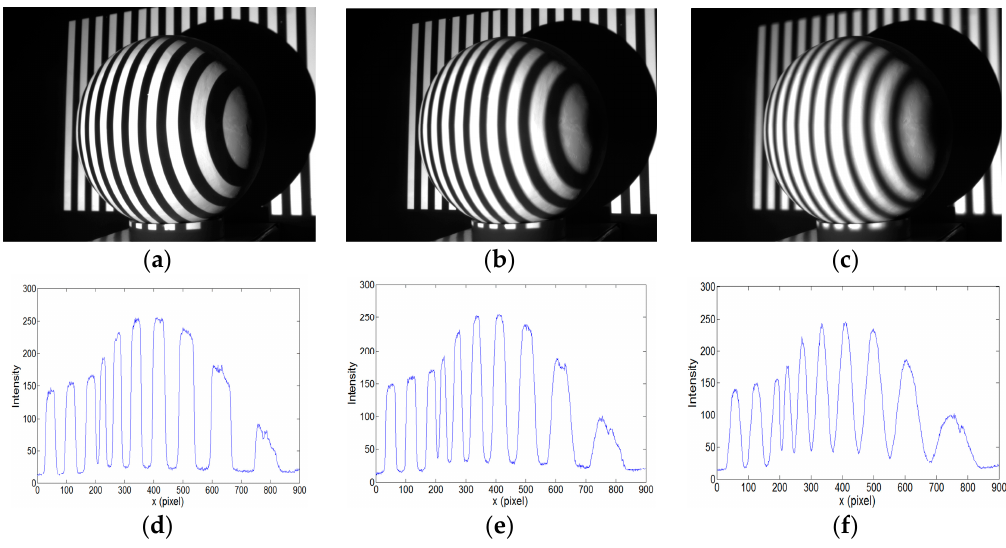
Figure 19. Illustration of three different defocusing degrees: ( a ) a captured fringe image under defocusing degree 1 (projector in focus); ( b ) a captured fringe image under defocusing degree 2 (projector slightly defocused); ( c ) a captured fringe image under defocusing degree 5 (projector very defocused); and, ( d – f ) Corresponding cross sections of the intensity of ( a – c ). Table 6. Statistics of the measurement results of hemisphere (unit: